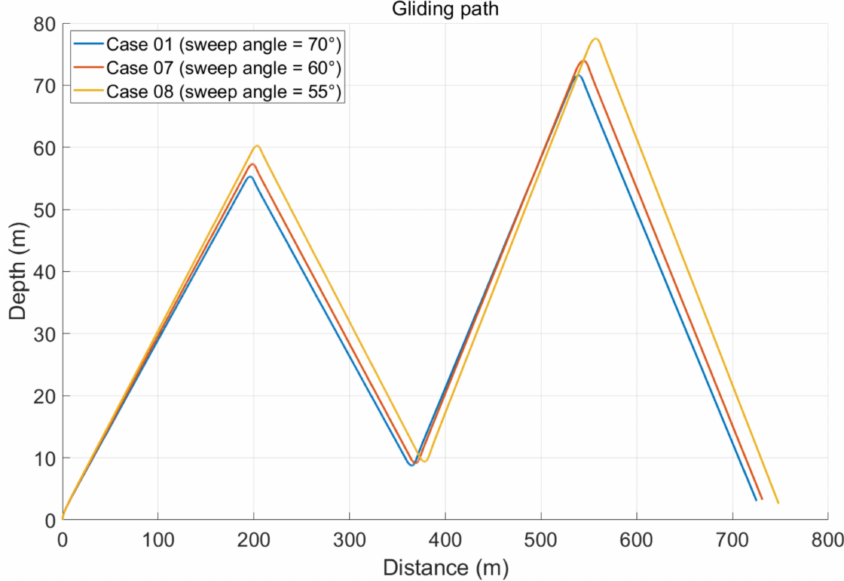
Figure 16. Simulation results of the gliding path in Cases 01, 07, and